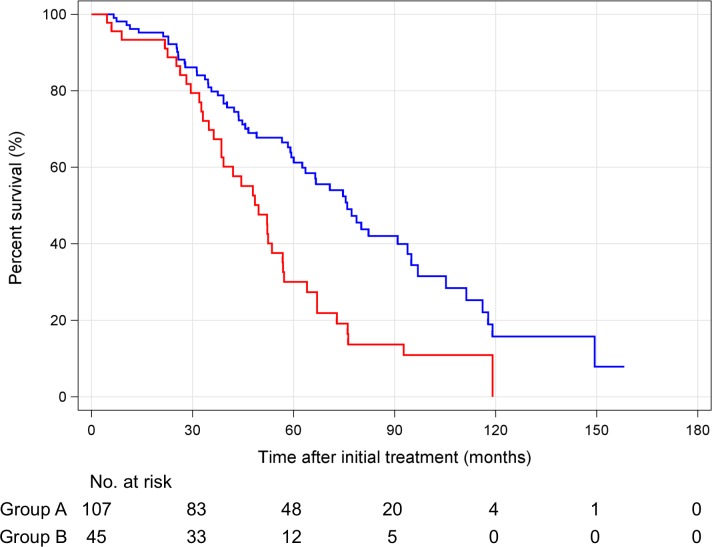
Kaplan–Meier survival curves for hypervascular hepatocellular carcinoma only (group A, blue line) and hypovascular nodules co-existing with hypervascular hepatocellular carcinoma (group B, red line).